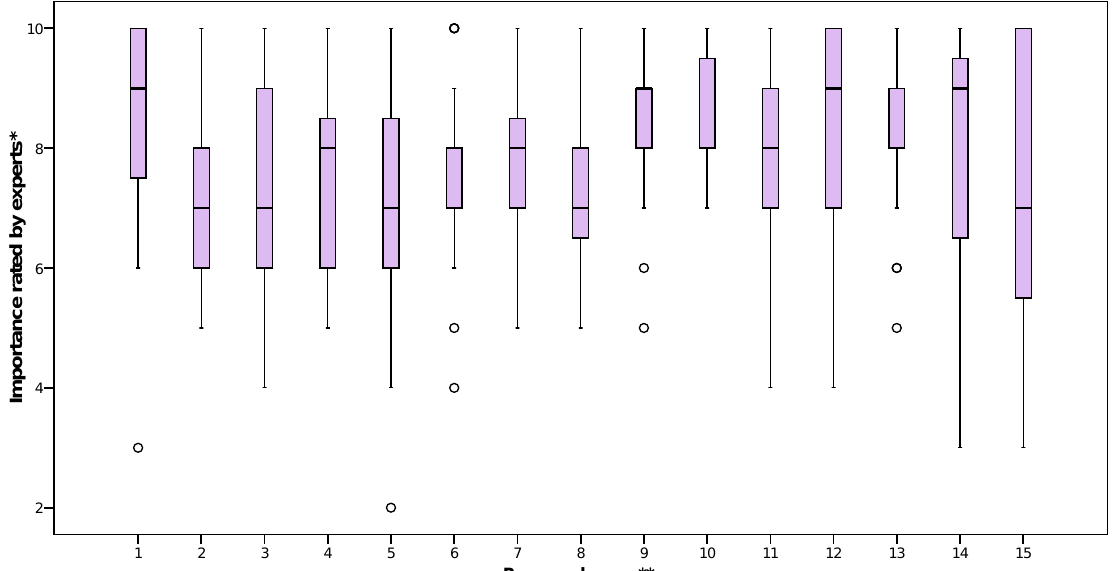
Figure. 1 : Distribution of experts‟ ratings on the importance of research areas in distance